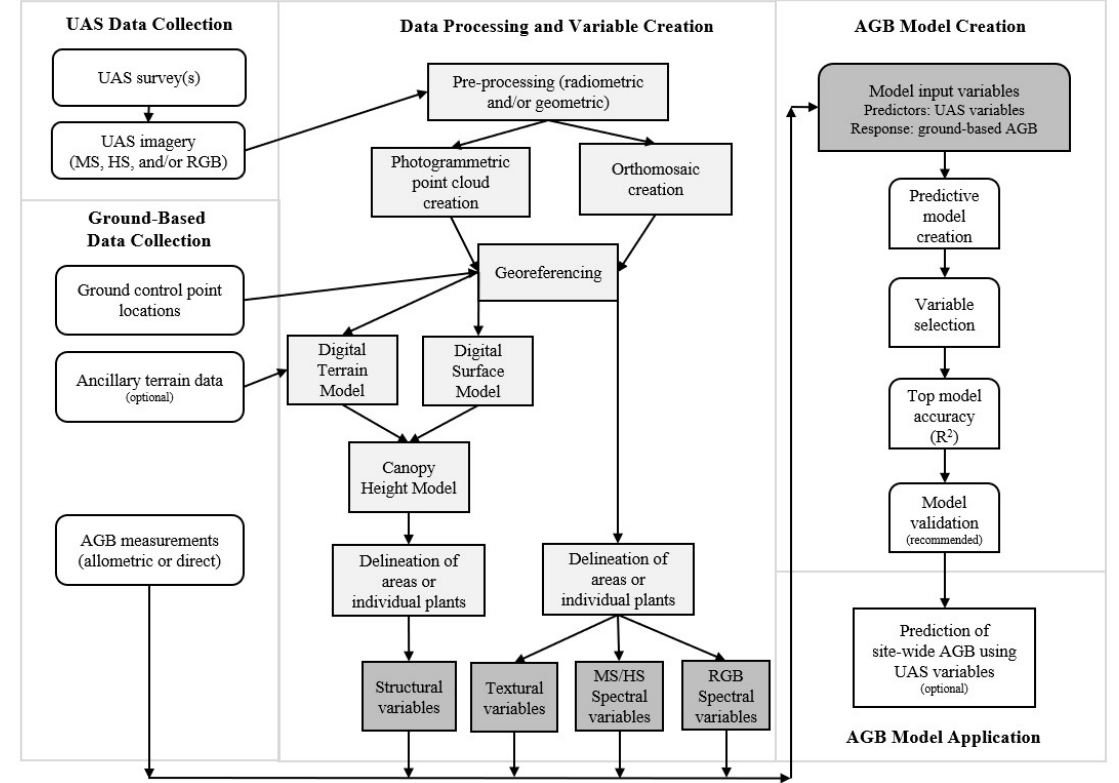
Figure 2. A schematic diagram of common steps used by studies summarized in this review for estimating the aboveground biomass (AGB) of vegetation using unmanned aerial system (UAS) data. Data collection steps are shown in rounded white rectangles; data processing in light grey rectangles; UAS-derived input data in dark grey rectangles; AGB model creation steps in white rectangles with rounded top corners; and model application in a white rectangle.